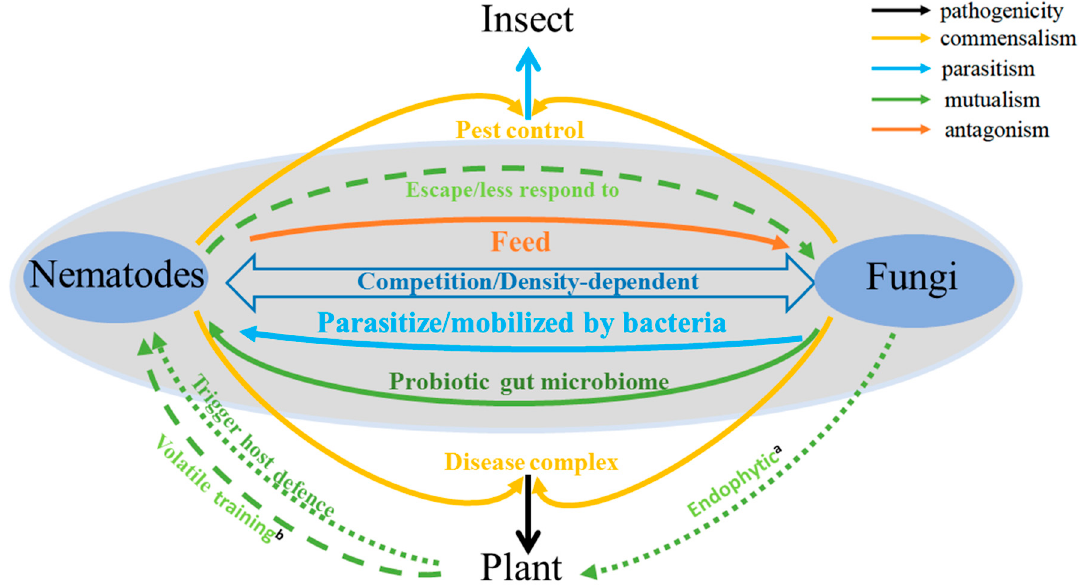
Figure 1. Fungi-nematode interactions in soil. a: Endophytic fungi trigger host plant defense against plant pathogenic nematodes (PPNs). b: Plants help nematodes escape fungal attacks through volatile training.